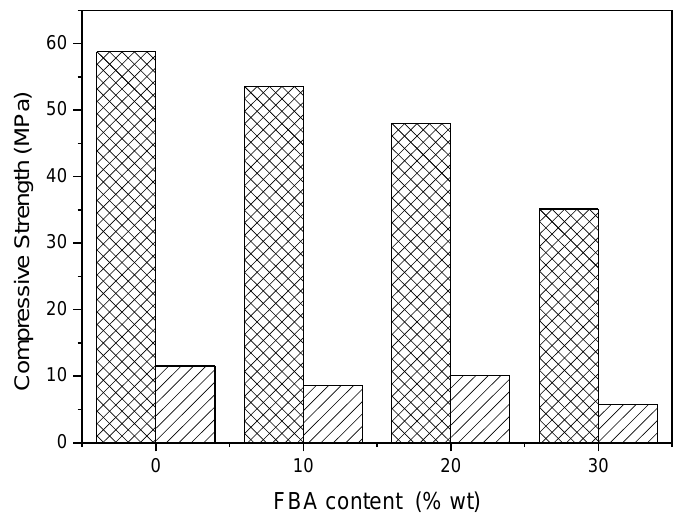
Figure 13. Compressive strength at different FBA contents at 30 °C and after thermal treatments up to 700 °C.